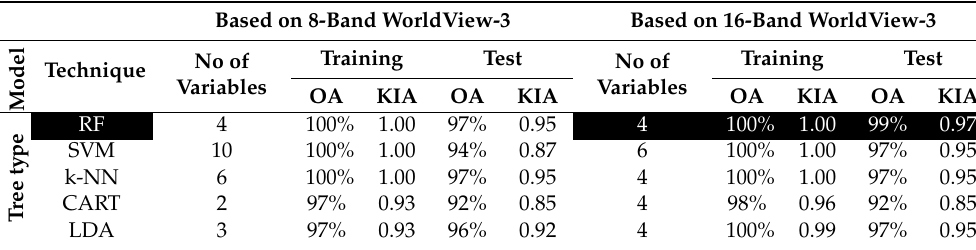
Table 5. Summary of the performance assessment using training and test sets for the five modelling techniques (RF, SVM, k-NN, CART and LDA) for the tree type (broadleaf / conifer) modeling approach. For tree mapping, the selected modeling technique with the highest overall accuracy (OA) is highlighted in dark. KIA: Kappa Index of agreement.